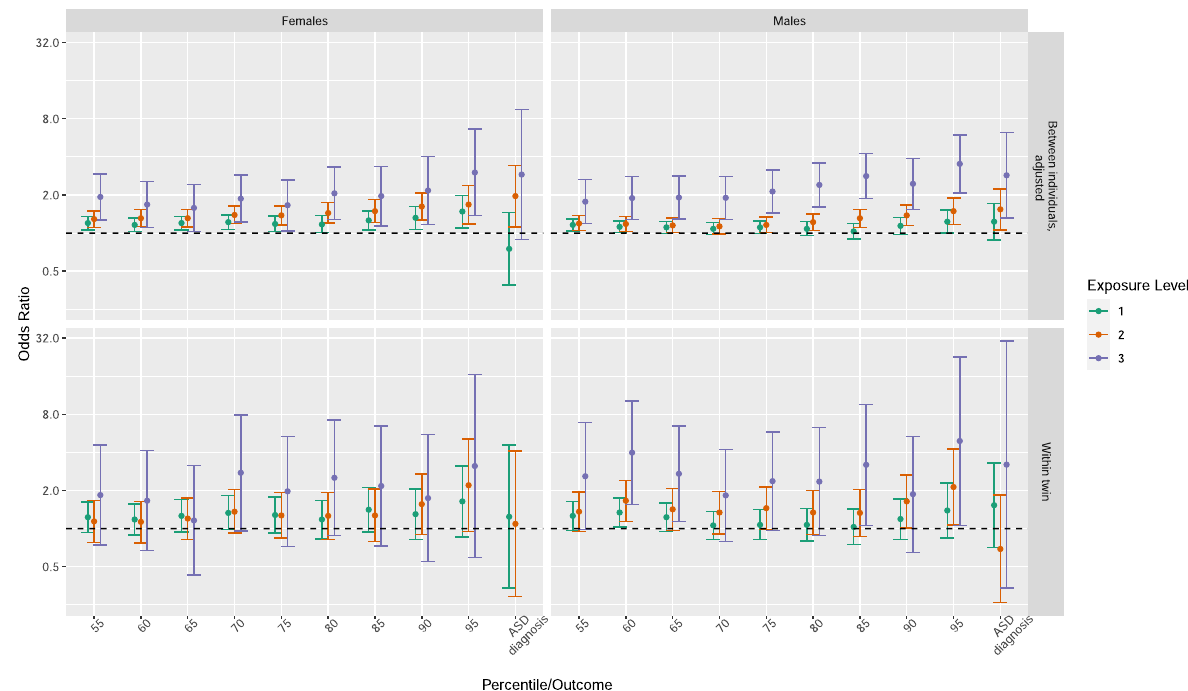
Fig. 3 Birthyear adjusted between individual (upper panels) and familial confounding adjusted within twin-pair (lower panels) associations between the cumulative exposure load of early medical factors and a diagnosis of ASD, and being above each percentile cut-off of autistic symptoms, respectively. Forest plots illustrating odds ratios (ORs, dots) and 95% con fi dence interval (CI, bars) from conditional regressions on females (left panels) and males (right panels), n = 10,254 twin pairs, excluding opposite sex